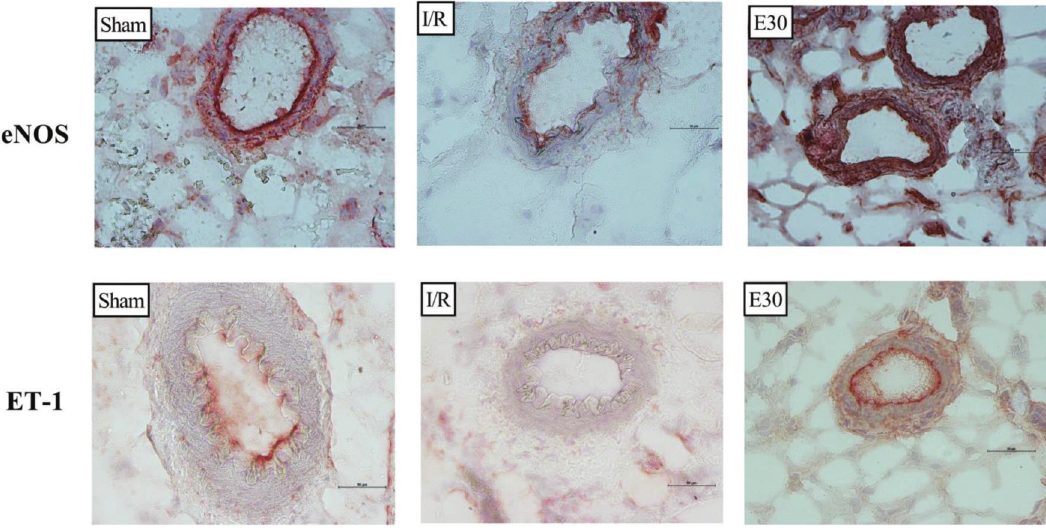
Figure 4 - Immunohistochemistry analysis of the expression of endothelial nitric oxide synthase (eNOS) and endothelin (ET-1) in mesenteric vessels. Original magnification, (cid:1) 40 for all images. In rats with I/R injury, the superior mesenteric artery was clamped (45 min), followed by intestinal reperfusion (2h). Estradiol (180 m g/kg, i.v.) was administered 30 min after the induction of intestinal ischemia (E30). Sham-operated rats were used as controls. I/R, ischemia and reperfusion.